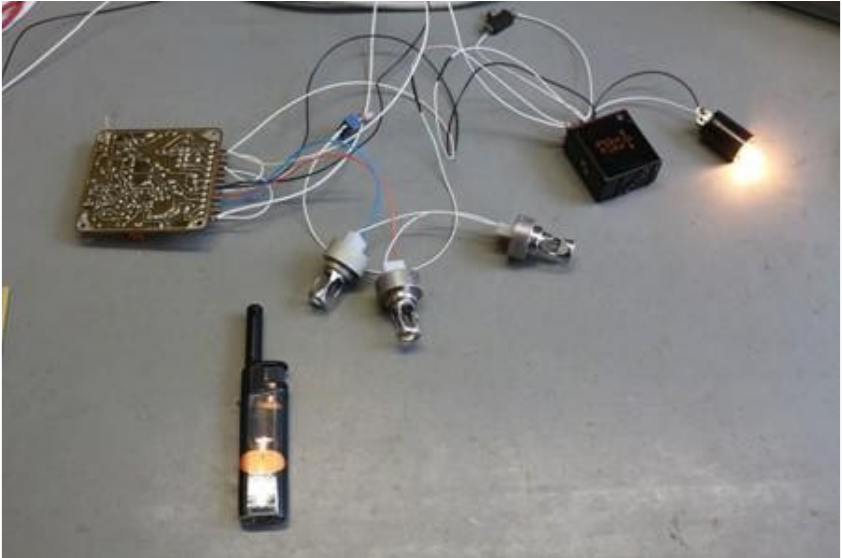
Figure 13. View of the measuring system for testing the block for disturbances in the supply voltage.